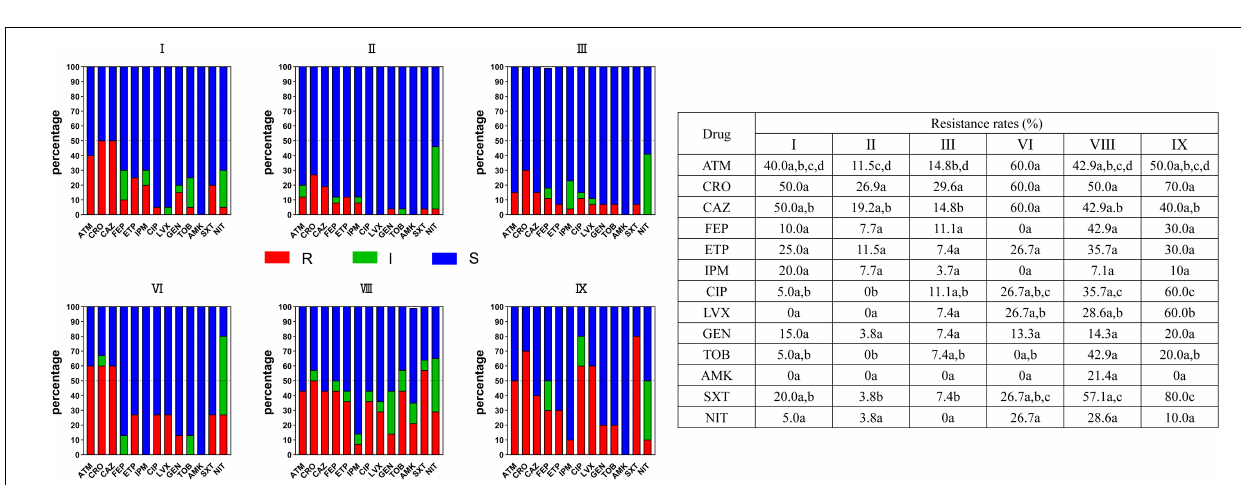
FIGURE 2 | Distribution of clinical strains within the genetic clusters of ECC. All strains could be assigned to one of the previously reported hsp60 gene sequencing-based genetic clusters of ECC. (A) Distribution of ECC isolates in clusters. Colored square indicates the source of the ECC strain. (B) Cluster distribution numbers for ECC isolates at various anatomical sites. Colored square indicates the clusters of the ECC strain. ECC, Enterobacter cloacae complex.